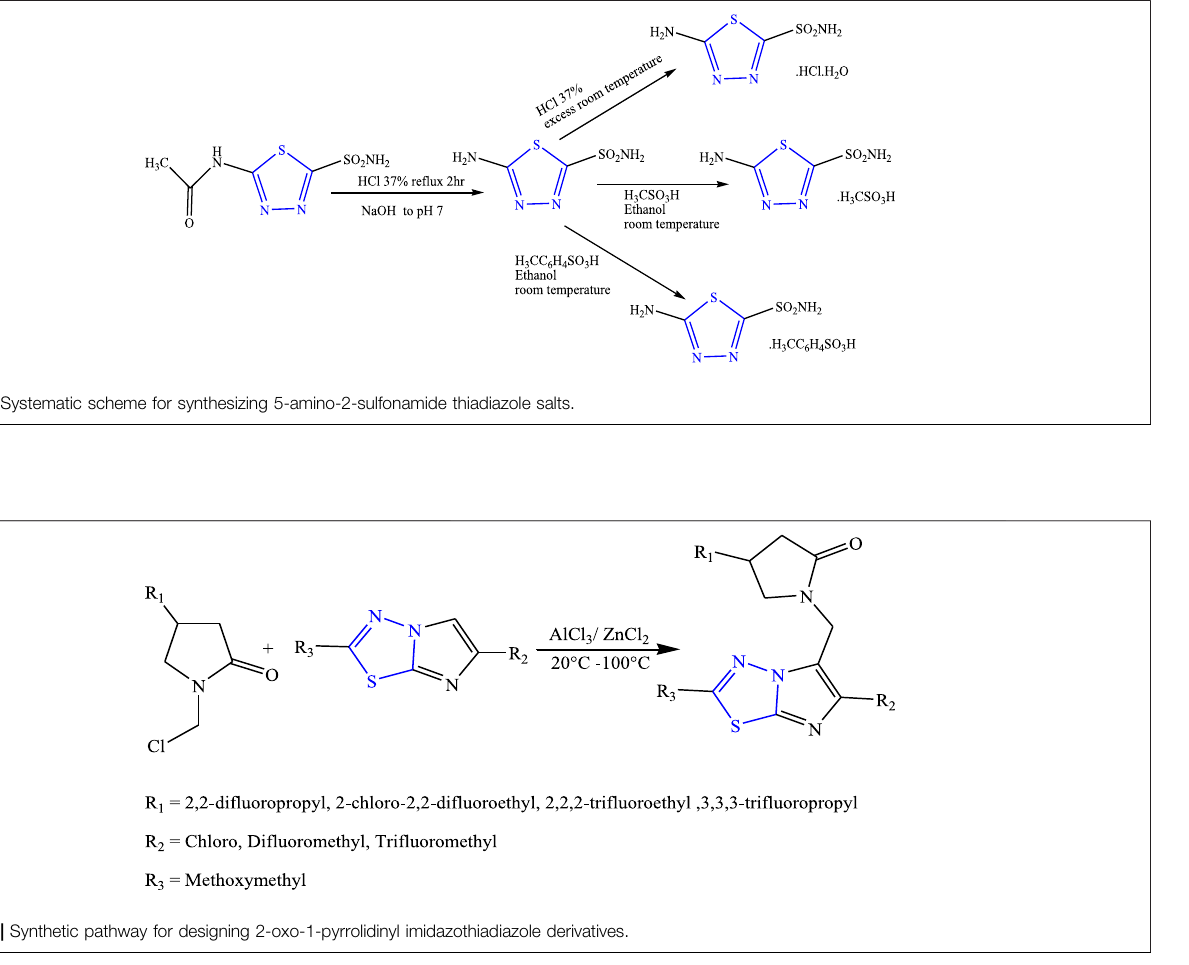
Frontiers in Chemistry |